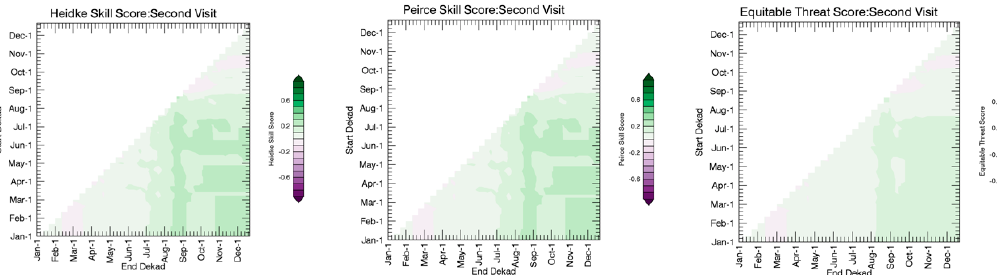
Figure 4. Histogram of farmer-reported “bad years” for 21 villages in Tigray; second visit.